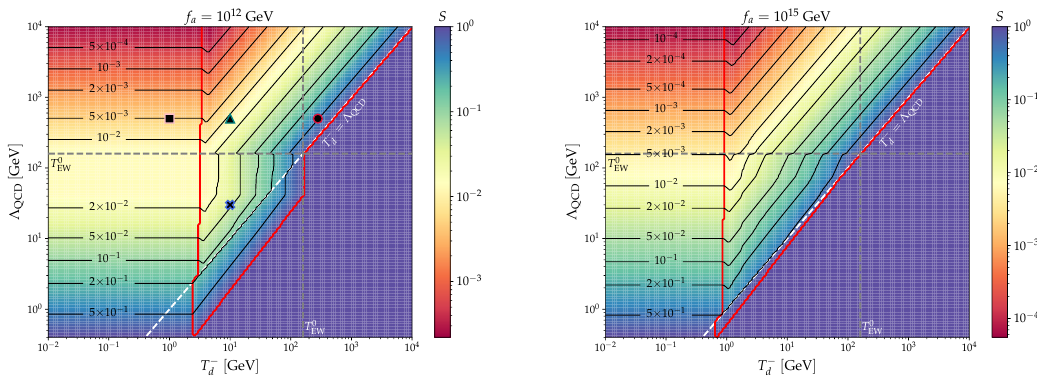
and Λ for f = 10 12 GeV , T Figure 4 . Contours of suppression factor S in the plane of T − QCD a osc ≈ d 2 . 4 GeV (left) and f = 10 15 GeV , T 0 . 67 GeV (right). The red lines bound the region where a osc ≈ damping and re-oscillation take place, the dashed grey lines label the EWSB scale in the SM, and the white dashed line marks the boundary below which early confinement never occurs. The solid markers in the left panel correspond to the four points shown in figure